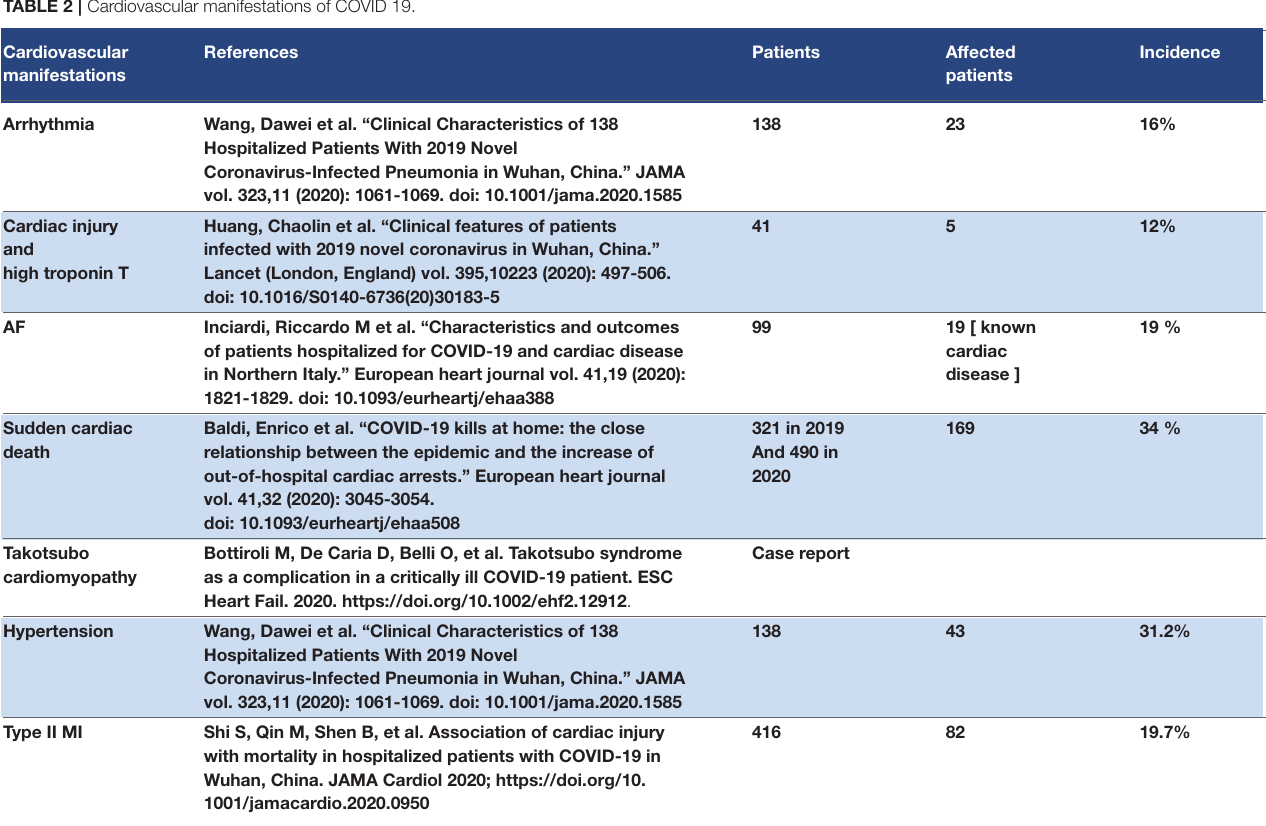
TABLE 2 | Cardiovascular manifestations of COVID